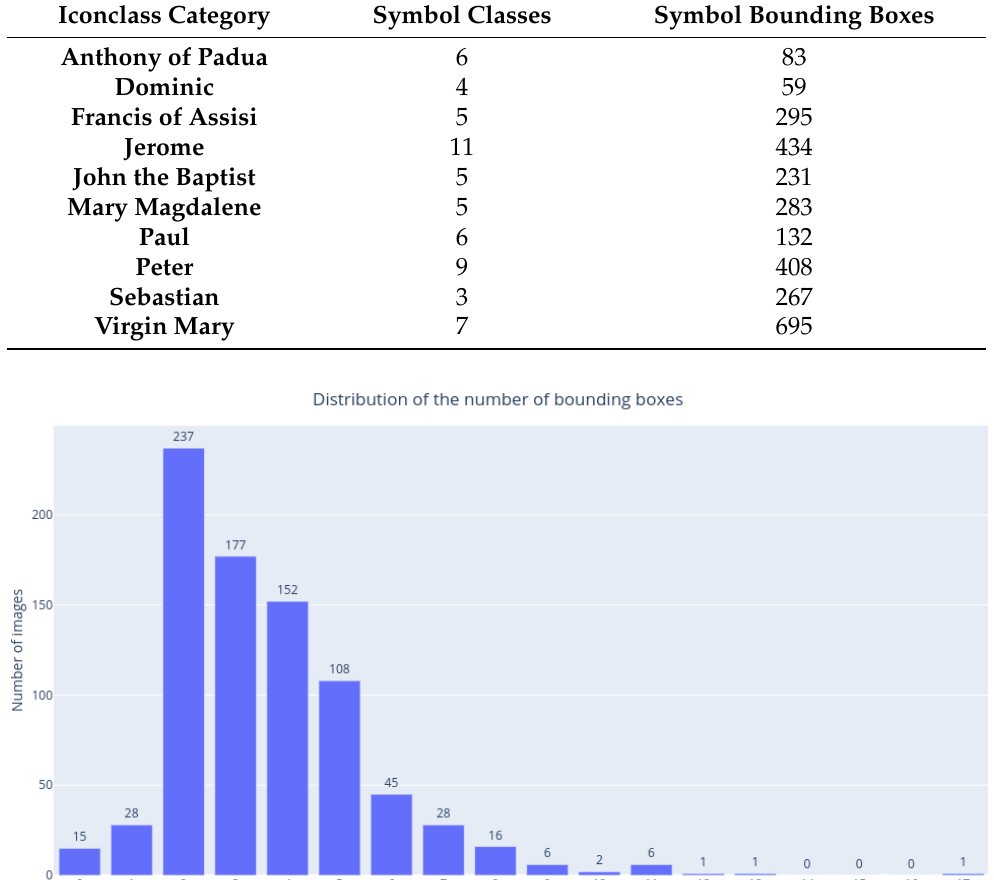
Table 2. Symbol and bounding box distribution.